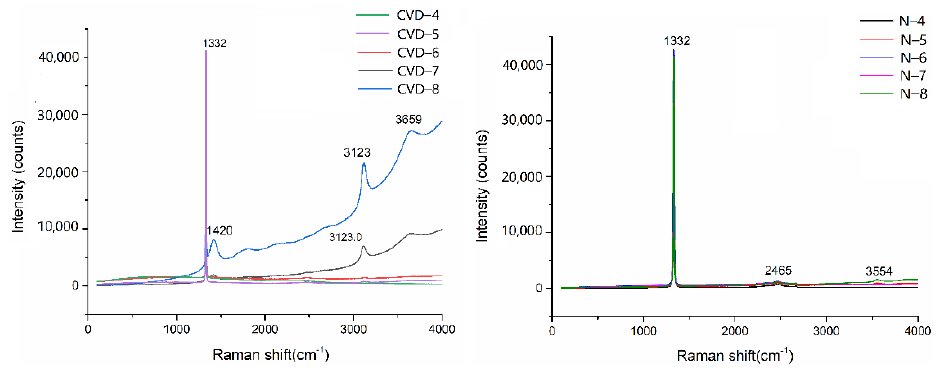
Figure 5. Raman spectra of low color grade (G–K) of samples.